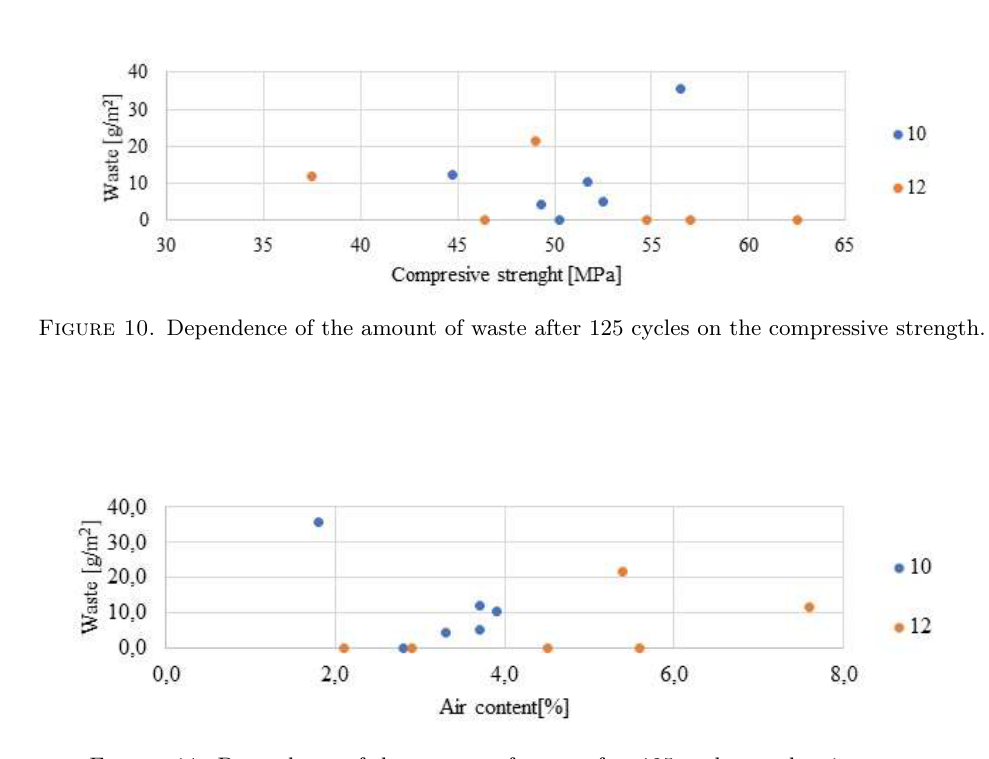
Figure 11. Dependence of the amount of waste after 125 cycles on the air content.